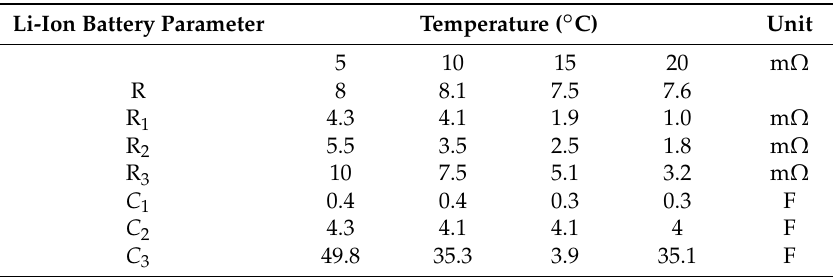
Table 2. Extracted Li-Ion 3RC EMC model